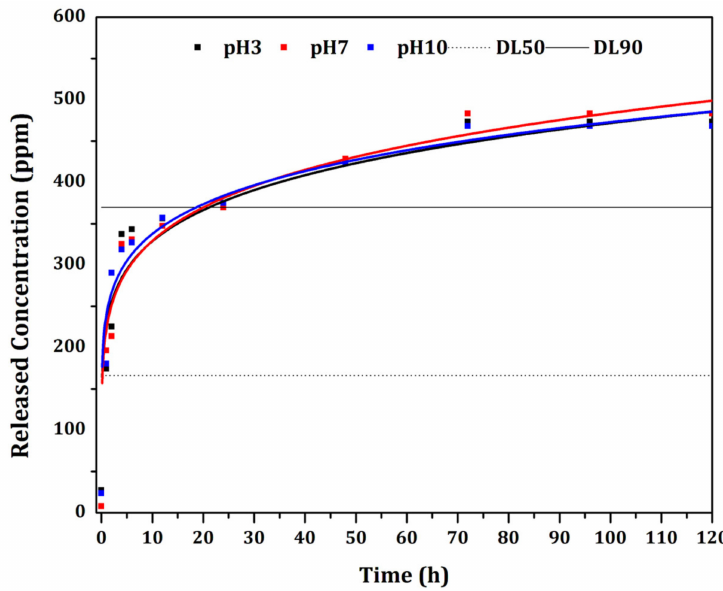
Figure 7. Controlled release curves of the biodefensive PNE at different pH (3, 7 and